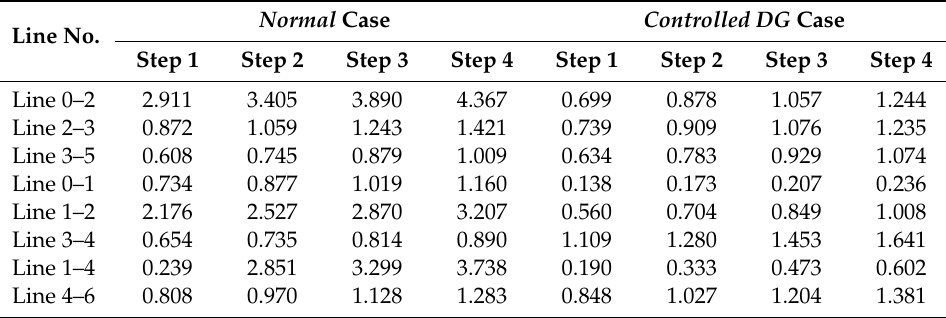
Table A7. Voltage drop values of lines for all steps and both cases (kV).